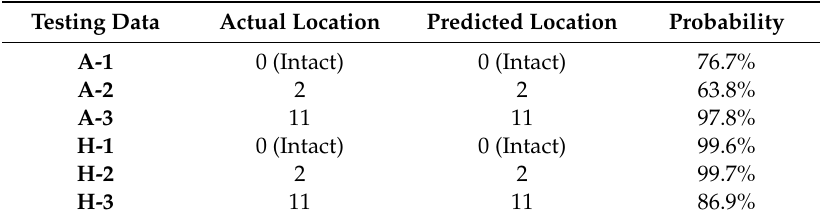
Table 6. Experimental verification results for single damage scenarios and intact structure.